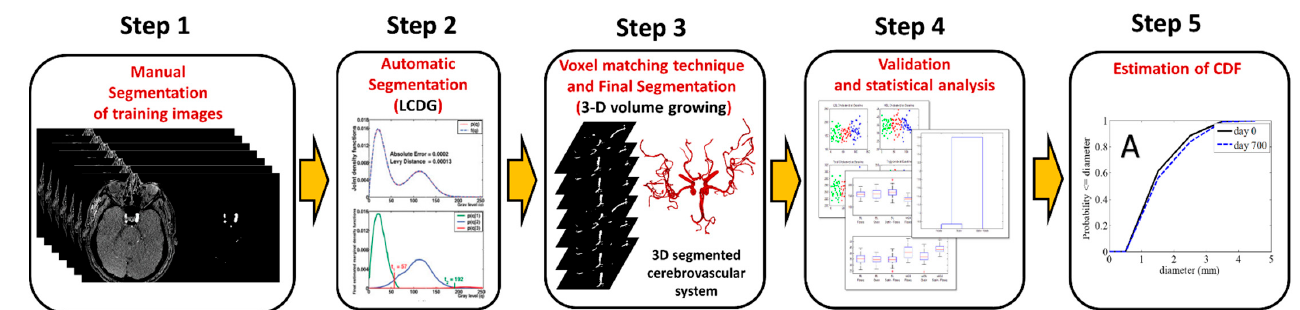
Figure 1. Framework of the data analysis for quantifying cerebrovascular changes from MRA imaging data.